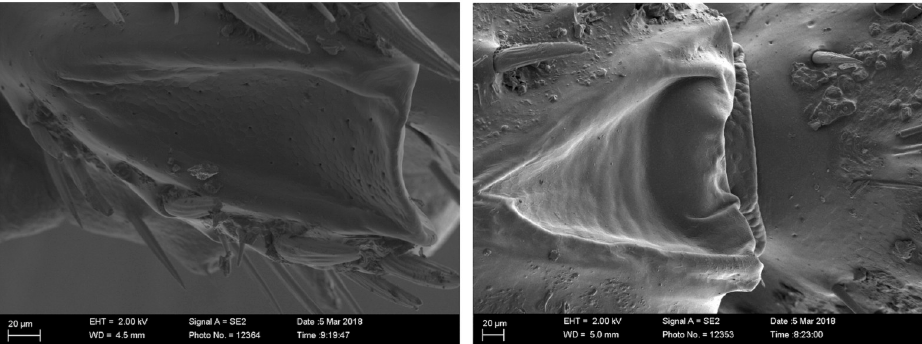
Fig 4. Scanning electron microscope of the triangle shape situated on the back of the basitarsus of S . noctilio . Many pores are visible in the triangle shape hind legs of the female (left) that were not visible on males (right).